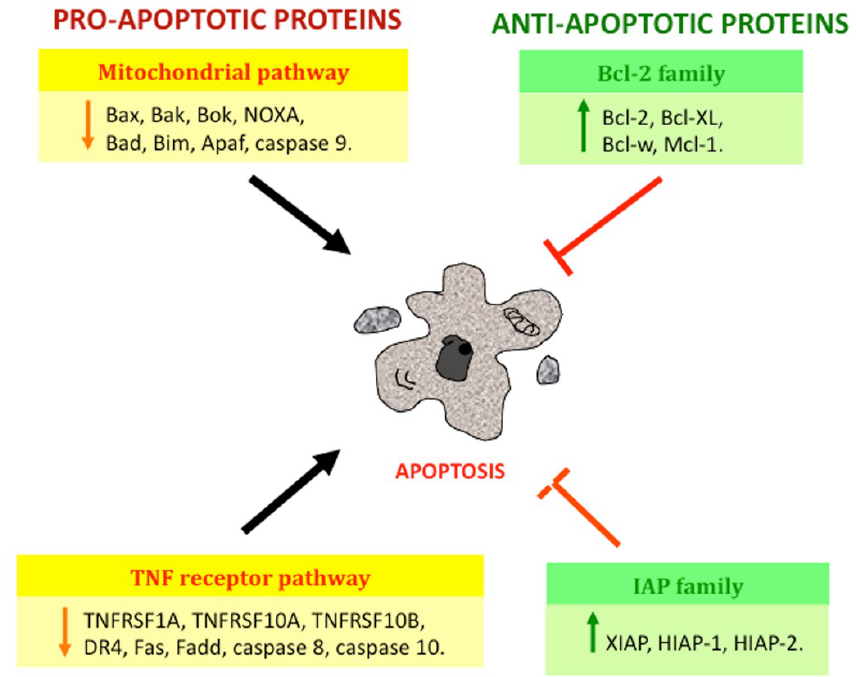
Figure 3. Status of proteins that participate in the apoptotic pathway in glioblastoma. An overexpression of anti-apoptotic proteins such as Bcl-2, Bcl-xL, Bcl-w, Mcl-1, XIAP, HIAP-1, and HIAP-2 has been reported, as well as a downregulation of pro-apoptotic proteins that participate in the mitochondrial apoptotic pathway (Bax, Bak, Bok, NOXA, Bad, Bim, Apaf, and caspase-9) and in the TNF receptor pathway (TNFRSF1A, TNFRSF10A, TNFRSF10B, DR4, Fas, Fadd, and caspase-8 and -9). It has been suggested that the dysregulation of these proteins induces resistance to apoptosis in different therapeutic approaches. Black arrows ( ↓ ) mean activation, red truncated arrows ( ⊥ ) mean inhibition. Down orange arrows mean downregulation ( ↓ ) and up green arrows mean upregulation ( ↑ ).